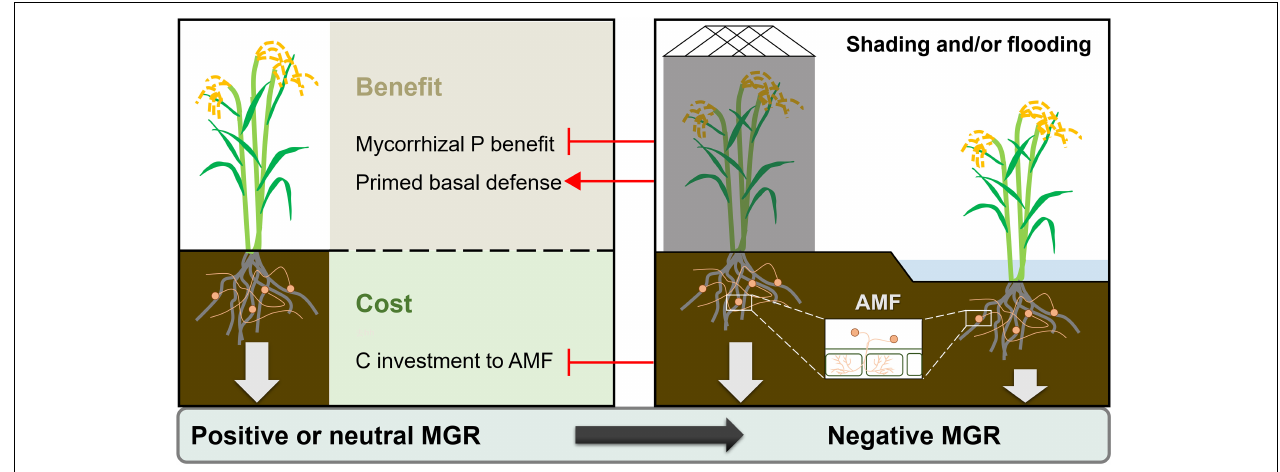
FIGURE 6 | Proposed model showing the effects of flooding or/and shading on the mycorrhizal growth response (MGR) of rice plants. (cid:97) : inhibitory effect, → : promotive